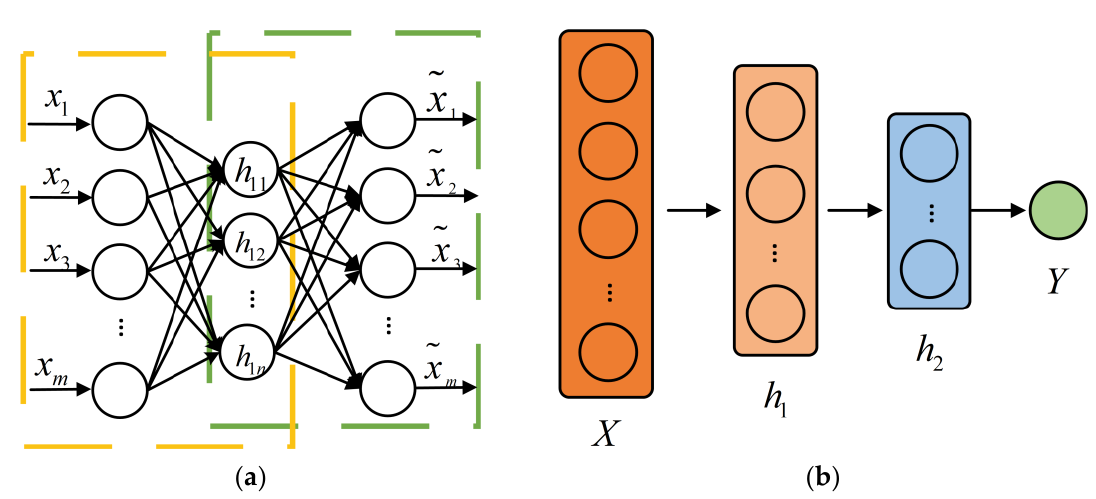
Figure 6. ( a ) Automatic encoder structure; ( b ) SAE structure.